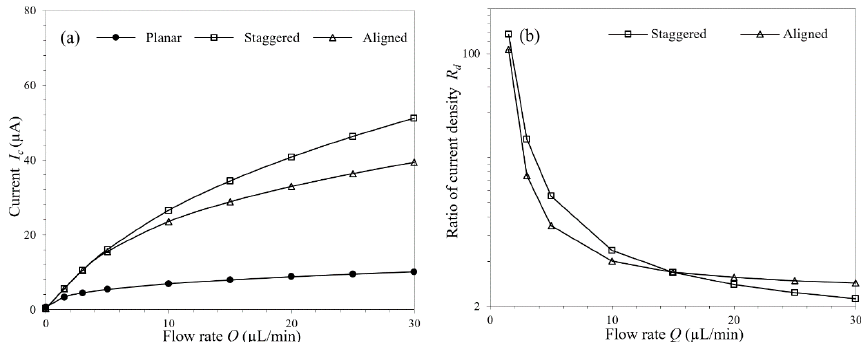
Figure 7. ( a ) Current responses of the planar electrode and the μ AEs in different layouts under varying flow rates; ( b ) The current density ratios of the μ AEs in different layouts under varying flow rates.